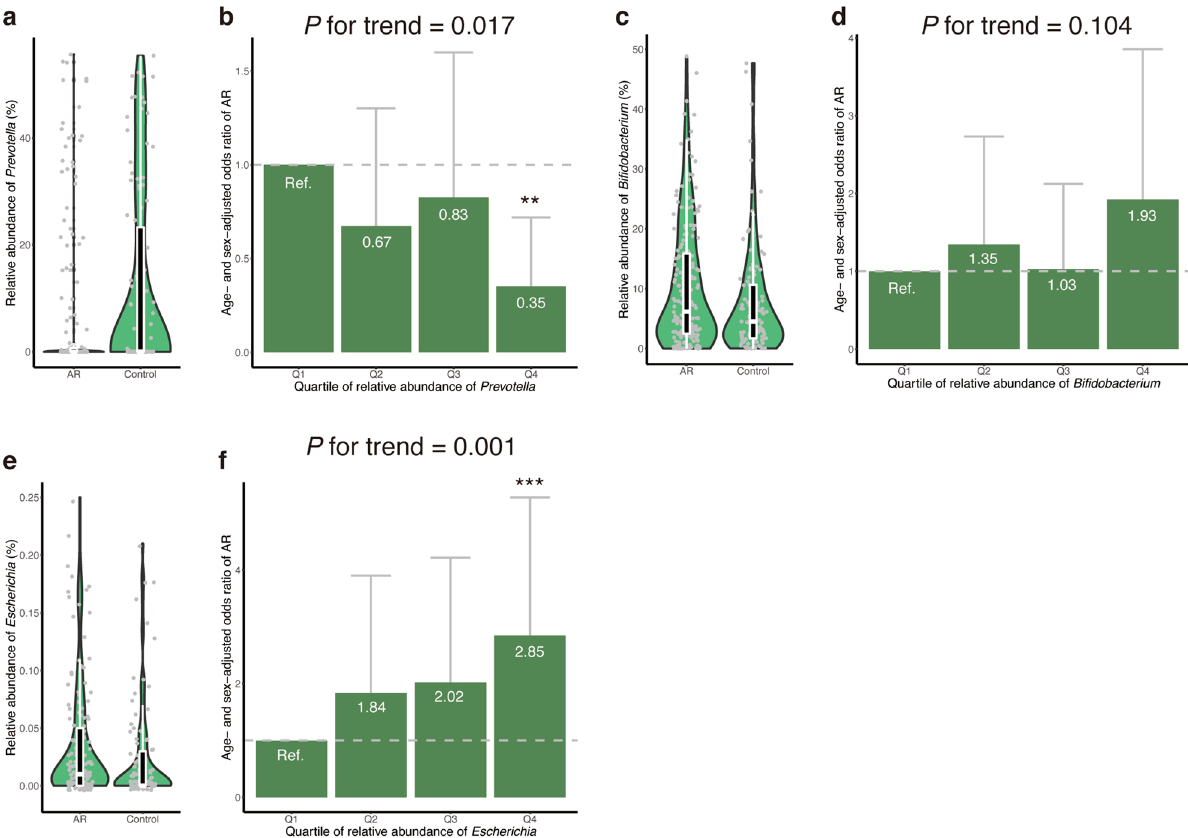
Figure 2. Gut microbial genera associated with allergic rhinitis. The distribution of relative abundance of gut microbial genera is shown for ( a ) Prevotella , ( c ) Bifidobacterium , and ( e ) Escherichia . Outlier data points are excluded from these plots. The age- and sex-adjusted odds ratio of allergic rhinitis is presented for ( b ) Prevotella , ( d ) Bifidobacterium , and ( f ) Escherichia . Error bars indicate 95% confidence interval. ‘*’ indicates P < 0.05; ‘**’, P < 0.01; and ‘***’, P < 0.001. AR, allergic rhinitis; Q, quartile; Ref., reference